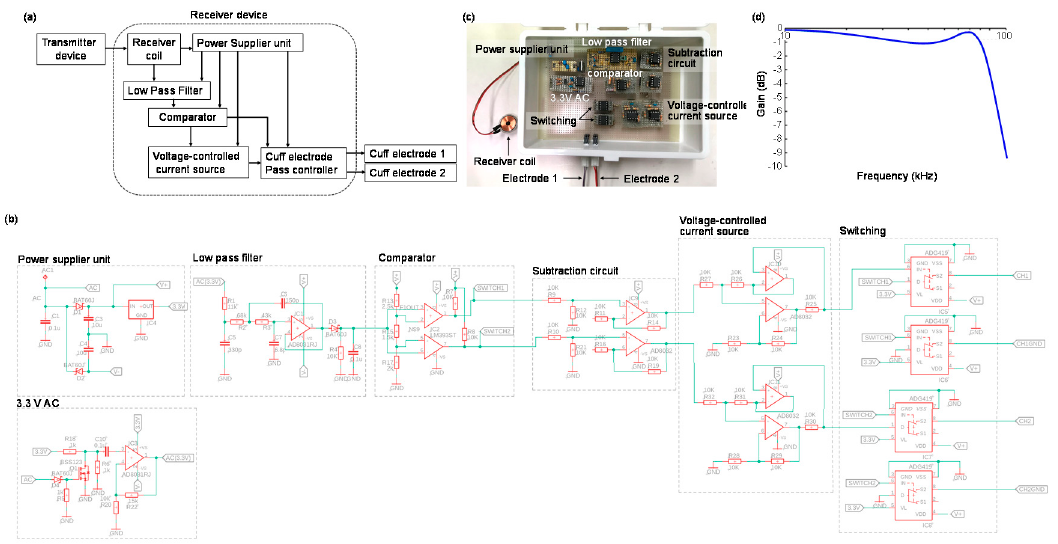
Figure 3. A receiver device system for visual feedback control of the rat ankle angle: ( a ) A schematic of the receiver device system; ( b ) The electrical circuit of the receiver device; ( c ) The fabricated receiver device; ( d ) The bode diagram of the low pass filter to identify the transmitter frequency.